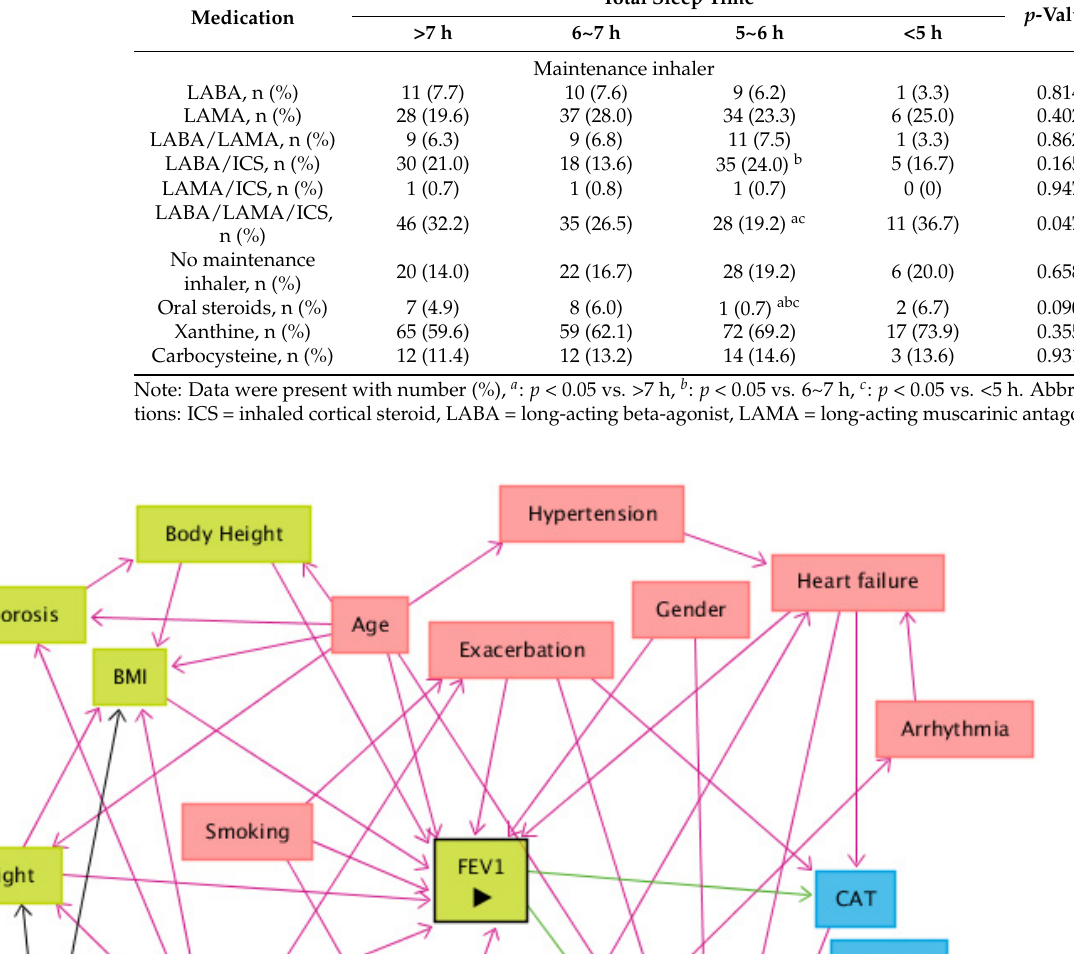
Table 4. Medication from four groups according to total sleep time.